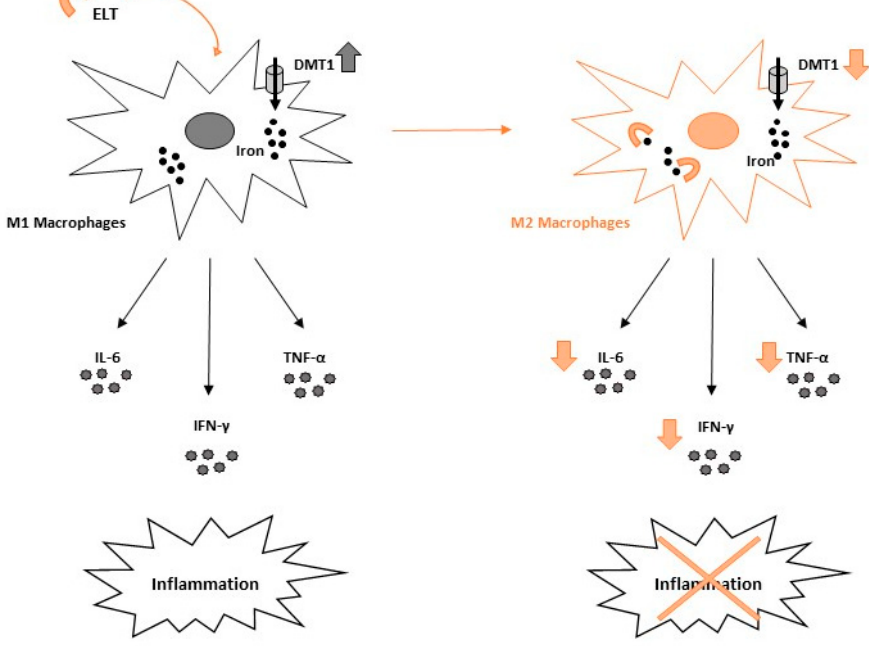
Figure 3. Eltrombopag effect on macrophages switch. Eltrombopag (ELT) administration induces a macrophage switch from the M1 pro-inflammatory phenotype towards the M2 anti-inflammatory one, by reducing intracellular iron concentration, divalent metal transporter 1 (DMT1) expression levels and pro-inflammatory cytokine release (Interleukin-6 (IL-6), tumor necrosis factor- α (TNF- α ), and interferon- γ (IFN- γ )), thus counteracting inflammation.